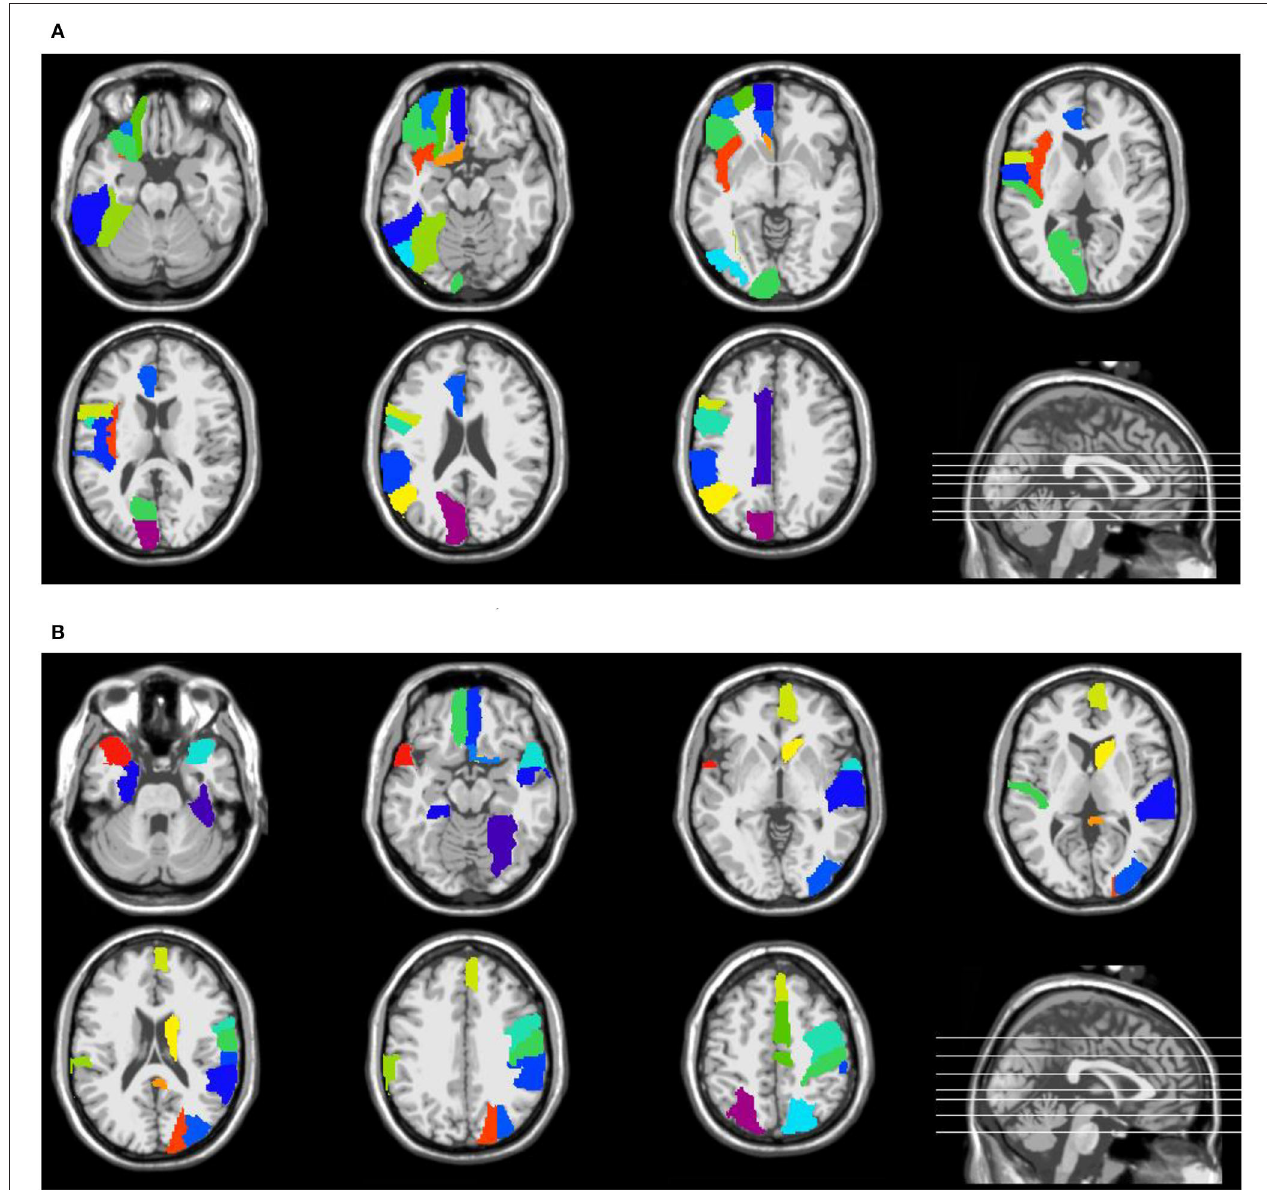
FIGURE 4 | Discriminative brain regions identified by the proposed method in (A) eMCI vs. NC classification and (B) AD vs. NC